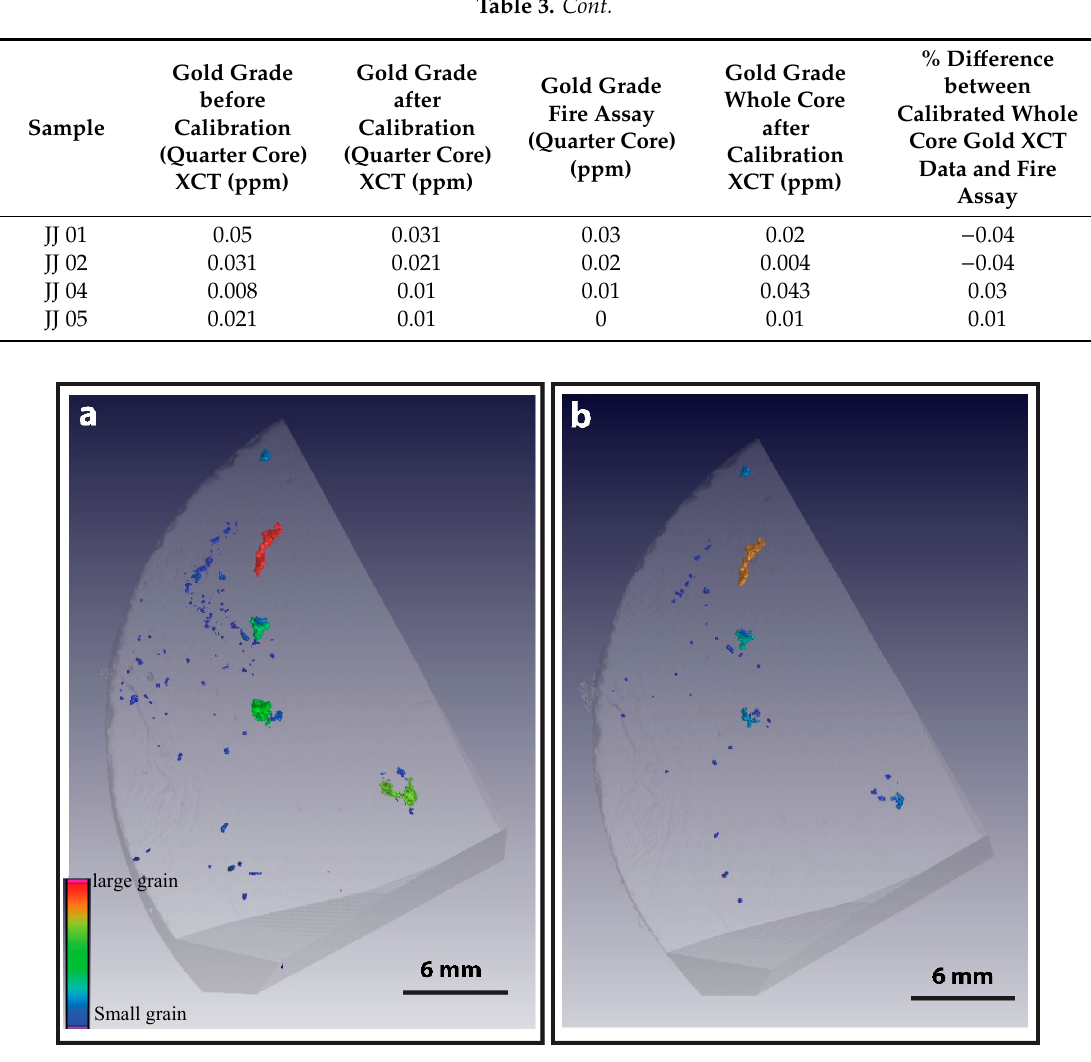
Figure 7. ( a , b ): Distribution of gold grains in the core after segmenting using a threshold value of 59,868 and 63,000 grey values respectively, at 59,868 XCT generally overestimate the mass of gold present in the core sample. The grey colour is the silicate matrix and other colours represent gold, distributed according to gold grain volume (warm colours = large grains, cold colours = smaller grains). Sample JJ01.